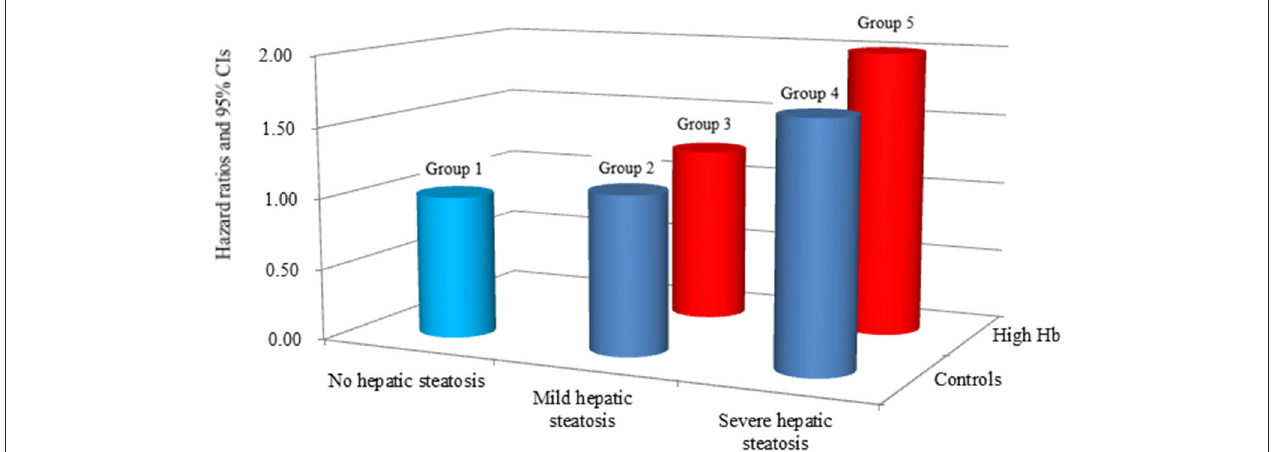
FIGURE 3 | Hazard ratios for incident ischemic heart disease according to hepatic steatosis and hemoglobin after adjusting for age, sex, body mass index, smoking status, alcohol intake, and physical activity.